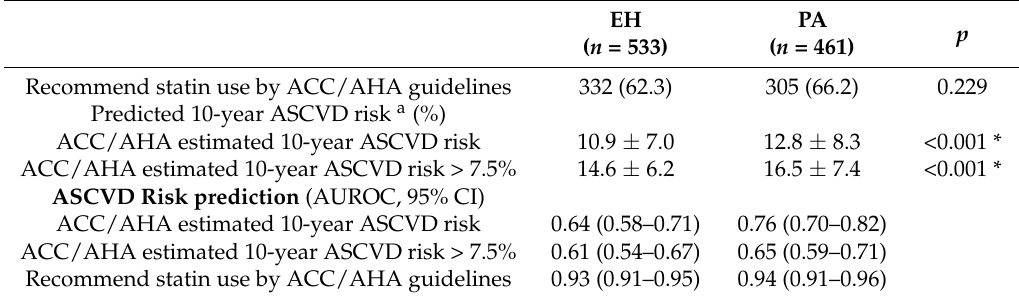
Table 2. The validation of the ACC/AHA guidelines on 10-year ASCVD risk in middle-aged hypertensive patients with EH and